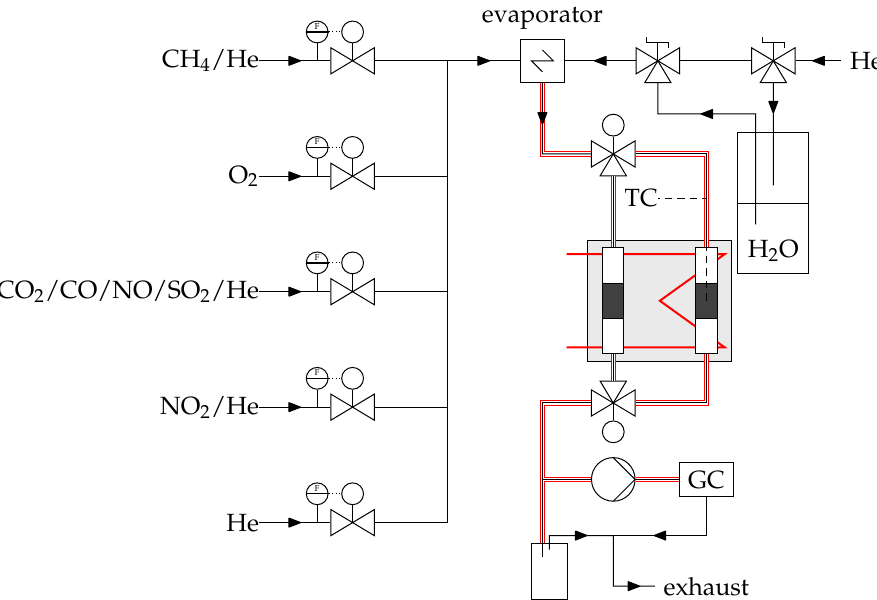
Figure 20. Schematic process diagram of the plug-flow reactor setup used for validation of results from